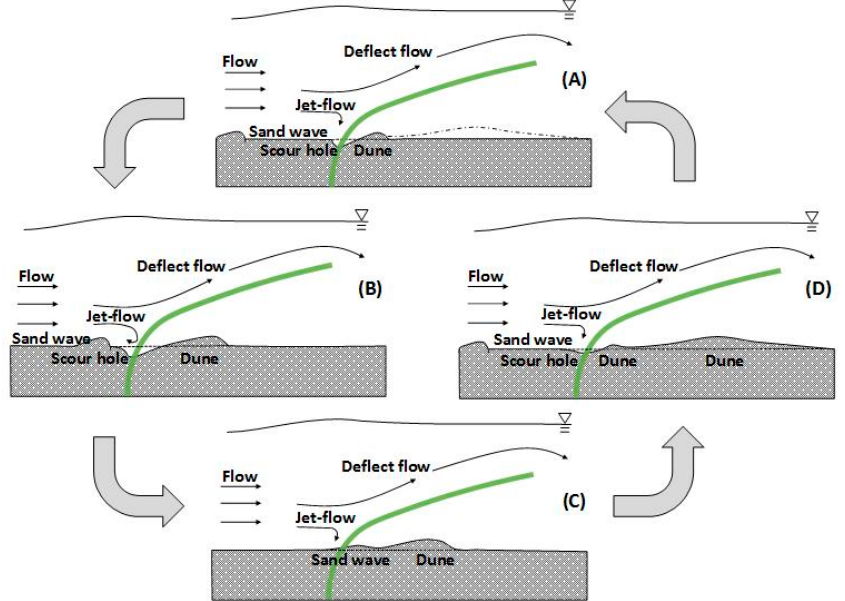
Figure 2. Schematic diagram of the sand-bed evolution. ( A ) Scouring stage. ( B ) Development stage. ( C ) Recovery stage. ( D ) Deposition stage.